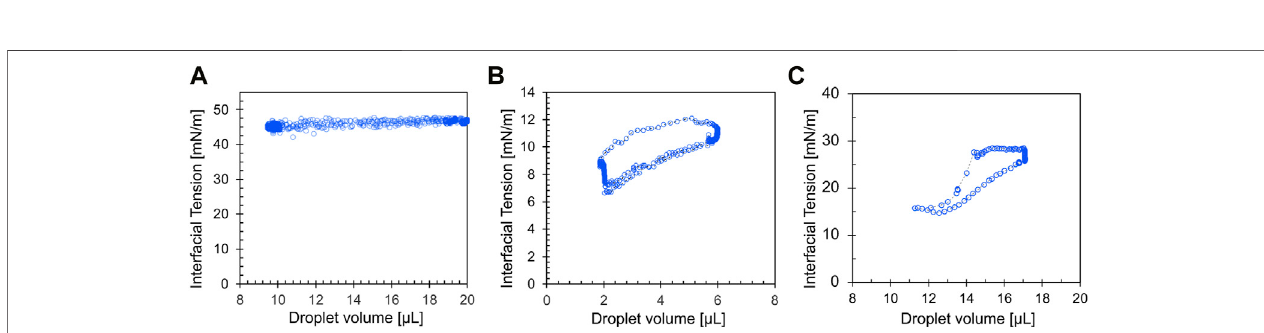
FIGURE 2 | Interfacial tension hysteresis. (A) Water droplet in decane. (B) CTAB solution droplet in decane. (C) Nano fl uid droplet in decane. (Benitez, 2022).